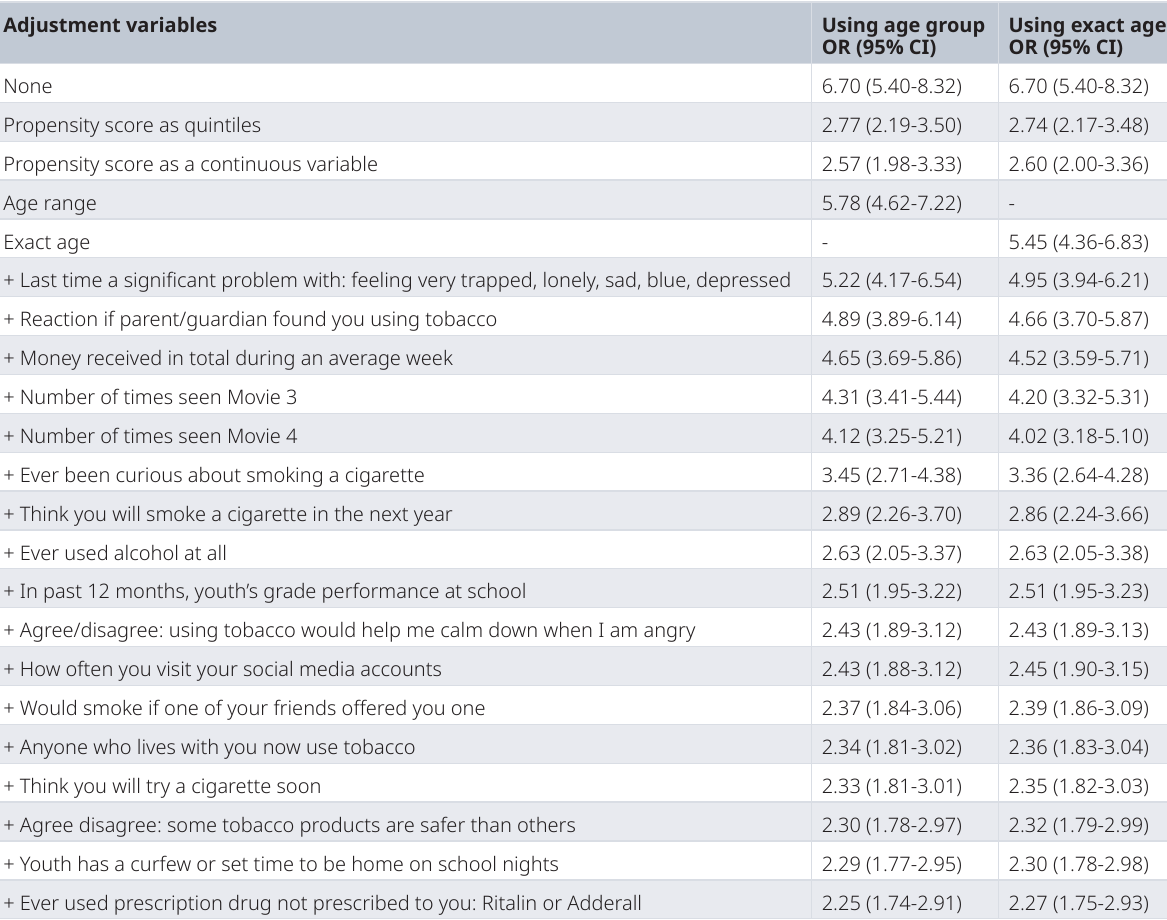
Table 4. Relating Wave 3 ever smoking to Wave 2 ever e-product use (Main analysis